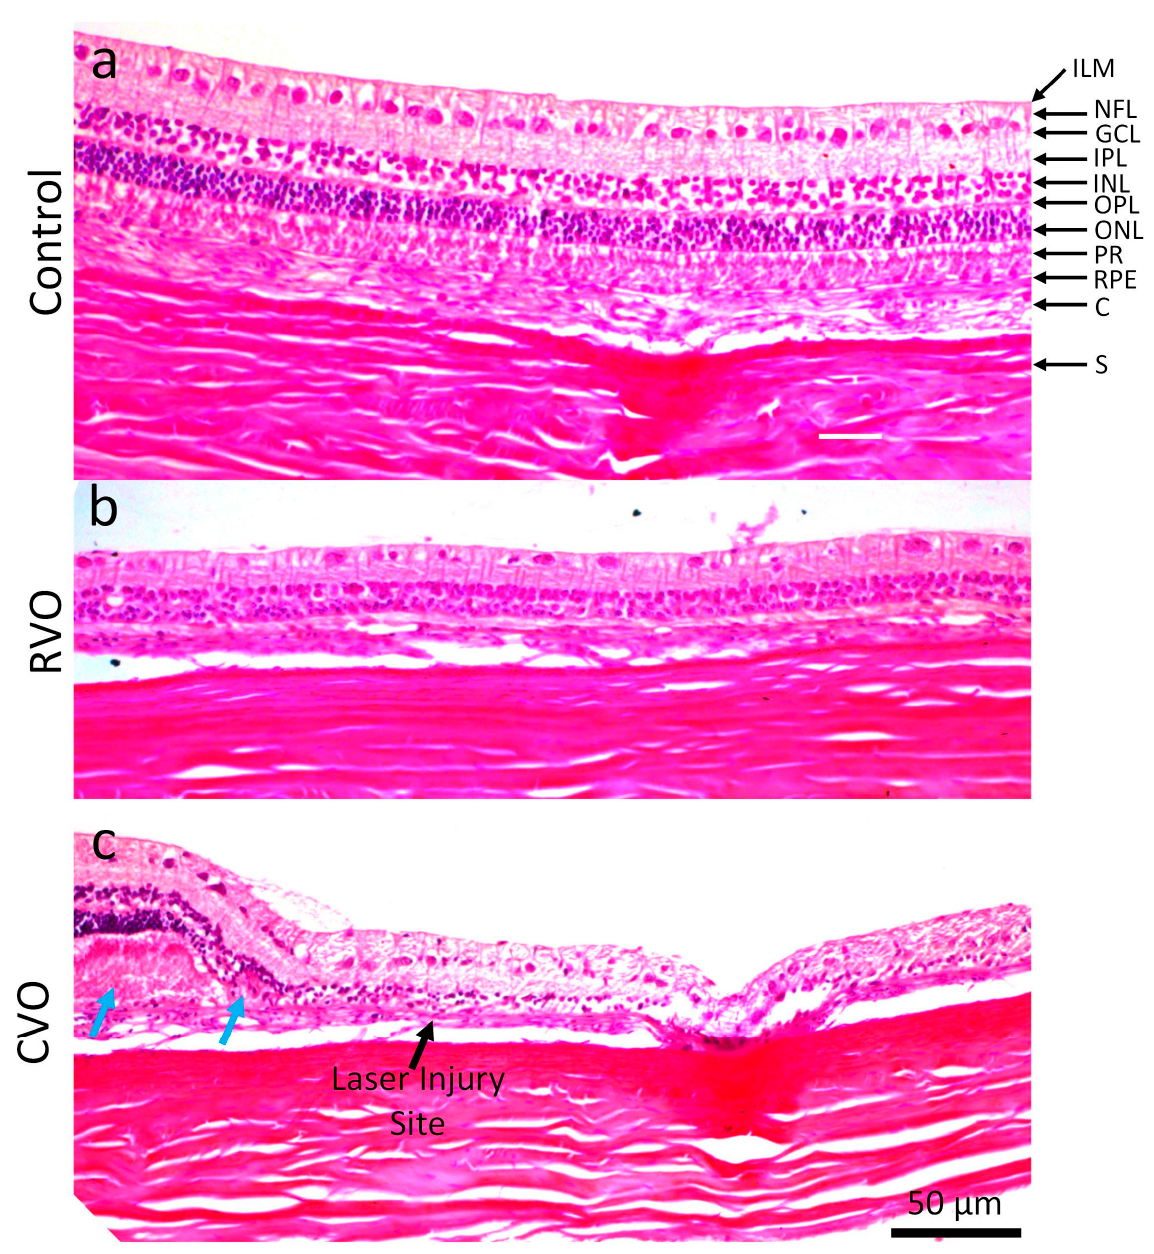
Figure 6. Histopathological analysis of RVO and CVO. ( a ) Hematoxylin and eosin (H&E) images of the retinal tissue without laser treatment. These images clearly show retinal anatomy with different layers. ( b , H&E images of RVO acquired at day 28 post-laser treatment. ( c ) H&E images of CVO. There were significant changes in the retinal architecture. Blue arrows show the focal area of the outer nuclear, photoreceptor, ganglion cells and inner nuclear layers at the affected region and is associated with loss of adjacent RPE and the morphology of the retina on side of the lesion (black arrow). Note that the retinal thickness was thinner than the control group. Magnification: × 20 and × 40. ILM: inner layer membrane; NFL: nerve fiber layer; GCL: Ganglion cell layer; IPL: Inner plexiform layer; INL: Inner nuclear layer; OPL: Outer plexiform layer; ONL: Outer nuclear layer; PR: Photoreceptors, C: Choroid; S: